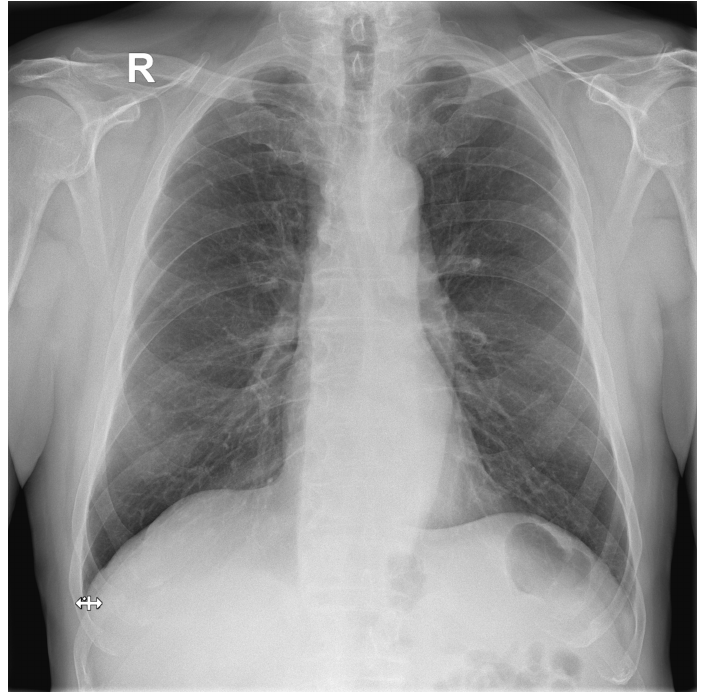
Figure A3. False Negative image #2 incorrectly classified by DLAD software during the retrospective study. The software failed to detect a lesion in lung parenchyma. Assessed radiologists #5f0, #442 and #c8a also incorrectly classified this image as